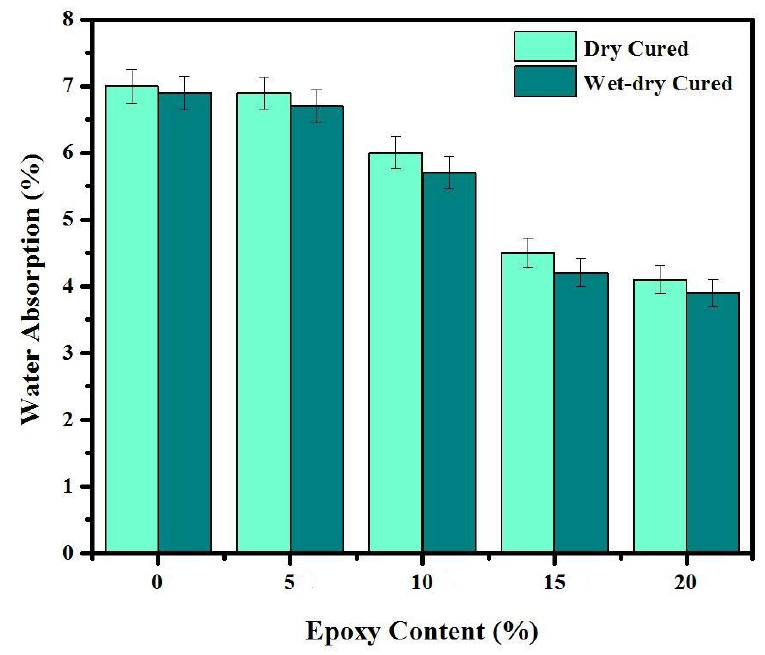
Figure 11. Effect of epoxy resin content and curing condition on water absorption.